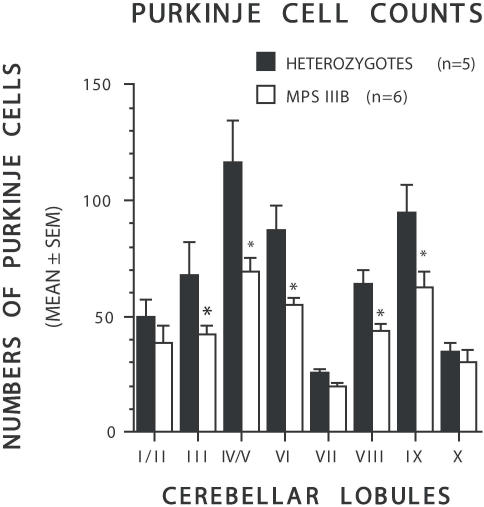
Age-related progressive loss of Purkinje cells in the cerebellar lobules in MPS IIIB mice.ANOVA of Purkinje cell count by lobe showed that old MPS IIIB mice (white bars) had significantly lower neuronal counts across cerebellar lobes compared to old heterozygous controls (black bars) although differences between groups were lobe dependent. Pairwise comparisons conducted in the older cohort of mice showed that differences between groups were greatest in lobes VI (*p = 0.001), IV/V (*p = 0.003), VIII (*p = 0.004), IX (*p = 0.011), and III (*p = 0.036). An ANOVA of the Purkinje cell count data that included both young and old cohorts of mice resulted in a significant main effect of Age (p<0.001) and a significant Age by Genotype interaction (p = 0.003). Other important effects included significant Lobe by Genotype (p = 0.010), and Lobe by Age (p<0.001) interactions. Additional comparisons showed that the older MPS IIIB mice had significantly fewer neurons across the cerebellar lobes compared to the younger MPS IIIB mice (p<0.001, (p<0.006, the Bonferroni corrected value)), while no differences were found between older and younger control mice.